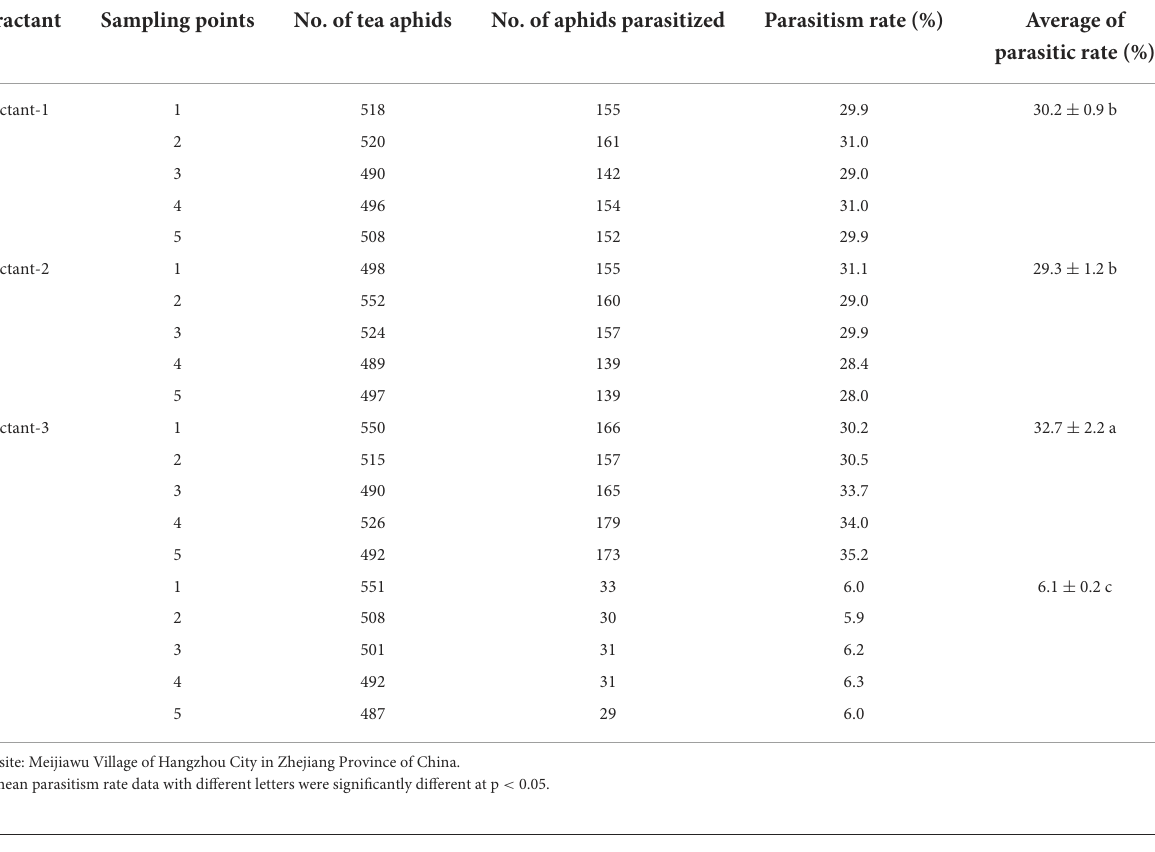
TABLE 7 Parasitism rates of tea aphids by Aphelinus sp. enticed and regulated by three attractant mixtures in comparison with untreated CK (Field trial 2).